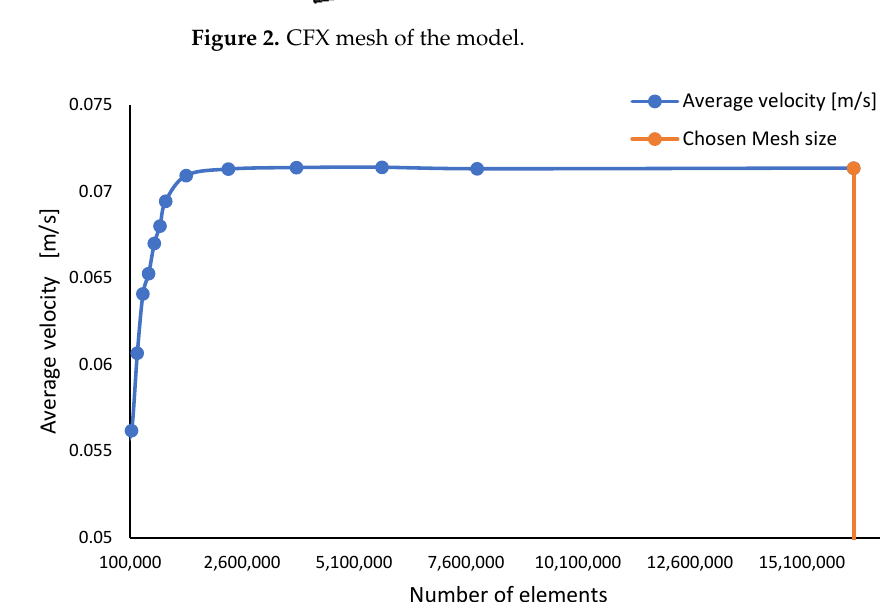
Figure 3. Mesh sensitivity analyses with respect to the average velocity at 1.7 m offset.